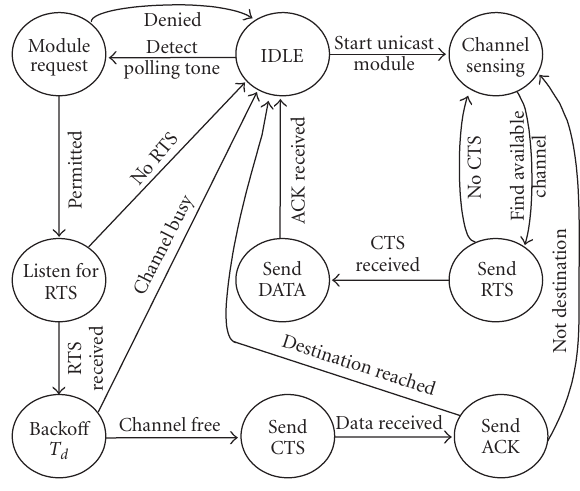
Figure 3: Wireless link layer state